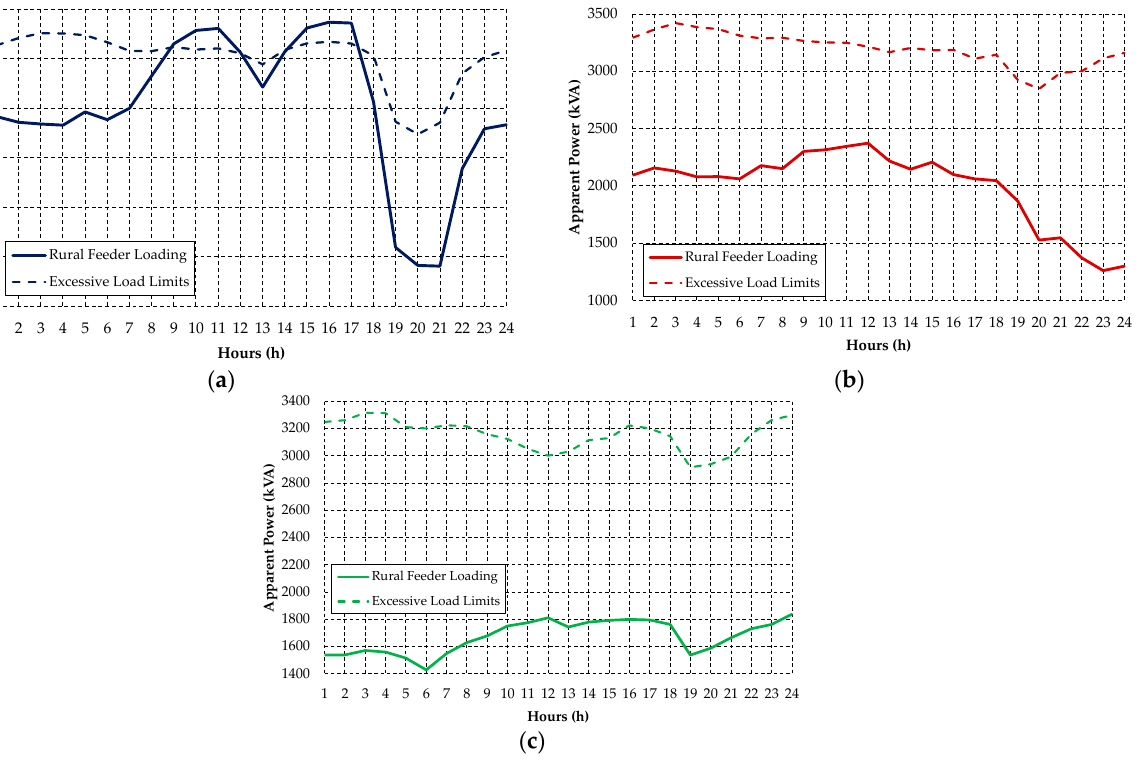
Figure 16. Apparent power and limits for excessive loading on the Rural Feeder B in the period of ( a ) weekday, ( b ) Saturday, and ( c ) Sunday. Source: The authors.